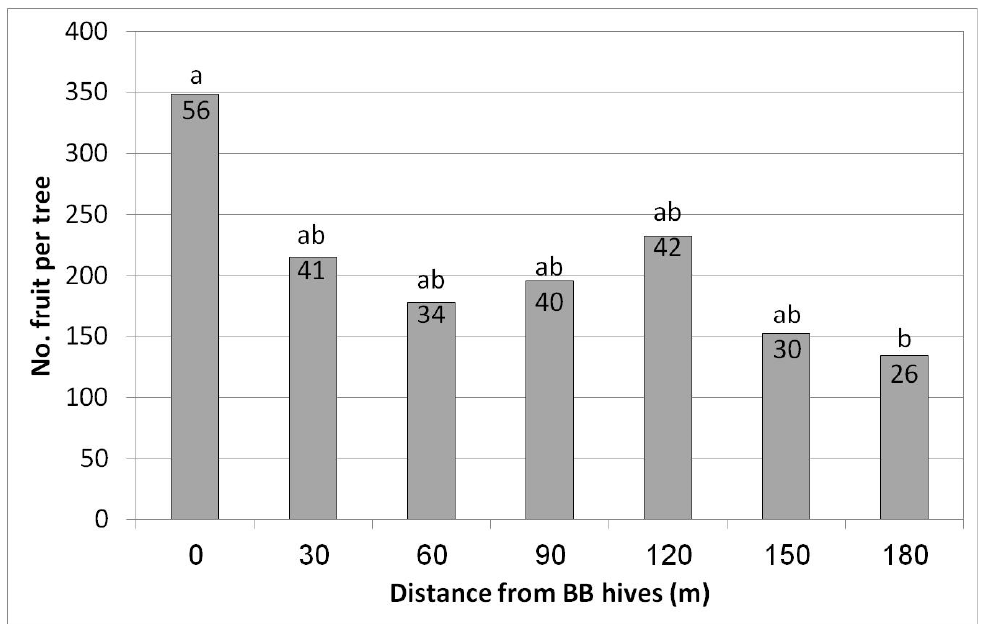
Figure 8. Effect of adding bumblebee (BB) hives (April 2019) on the number of fruit per tree and kilogram of fruit per tree (no. in the column) in February 2020 at seven distances from the BB hives, Eyal, 2019/20. Results in a column followed by different letters differ significantly according to Duncan’s new multiple range test, p < 0.05. Data are the means of five ‘Hass’ trees at each distance.